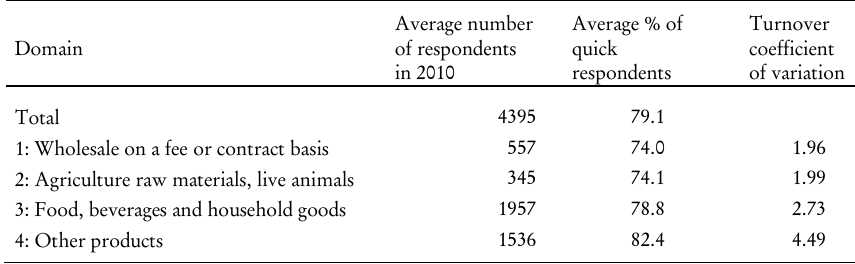
Number of final respondents (average 2010), share of quick respondents and coefficient of variation of turnover for the panel of wholesale trade enterprises included in the comparative exercise for testing efficiency of various estimation strategies Average number Average % of Turnover of respondents Domain quick coefficient in 2010 respondents of variation Total 4395n